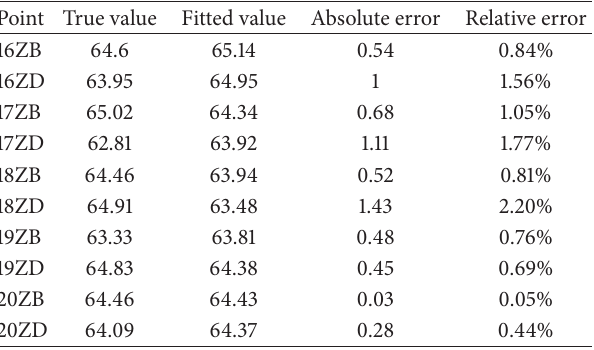
Table 6: The error analysis of all the 90 groups training dB.